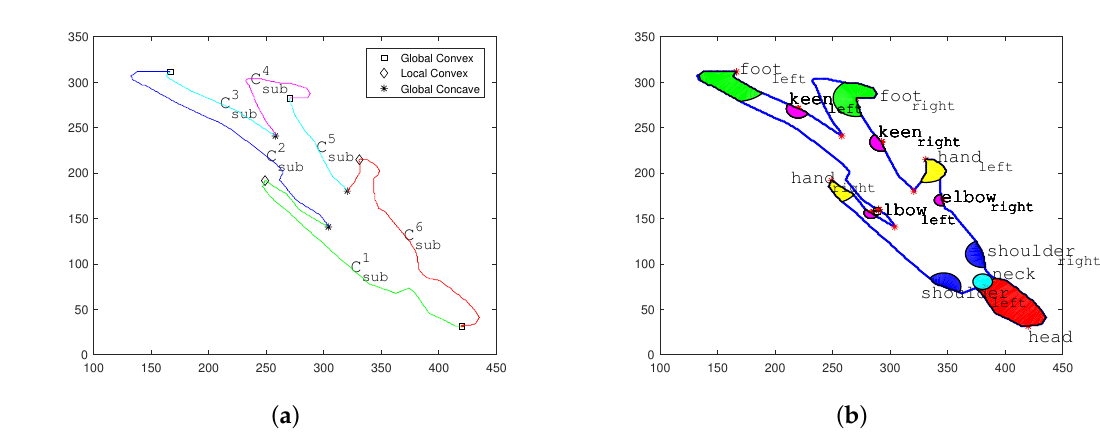
Figure 2. Silhouette information analyses and joint position extraction. ( a ) Sub-curve segmentation; ( b ) two-dimensional (2D) joint position extraction on the shadow